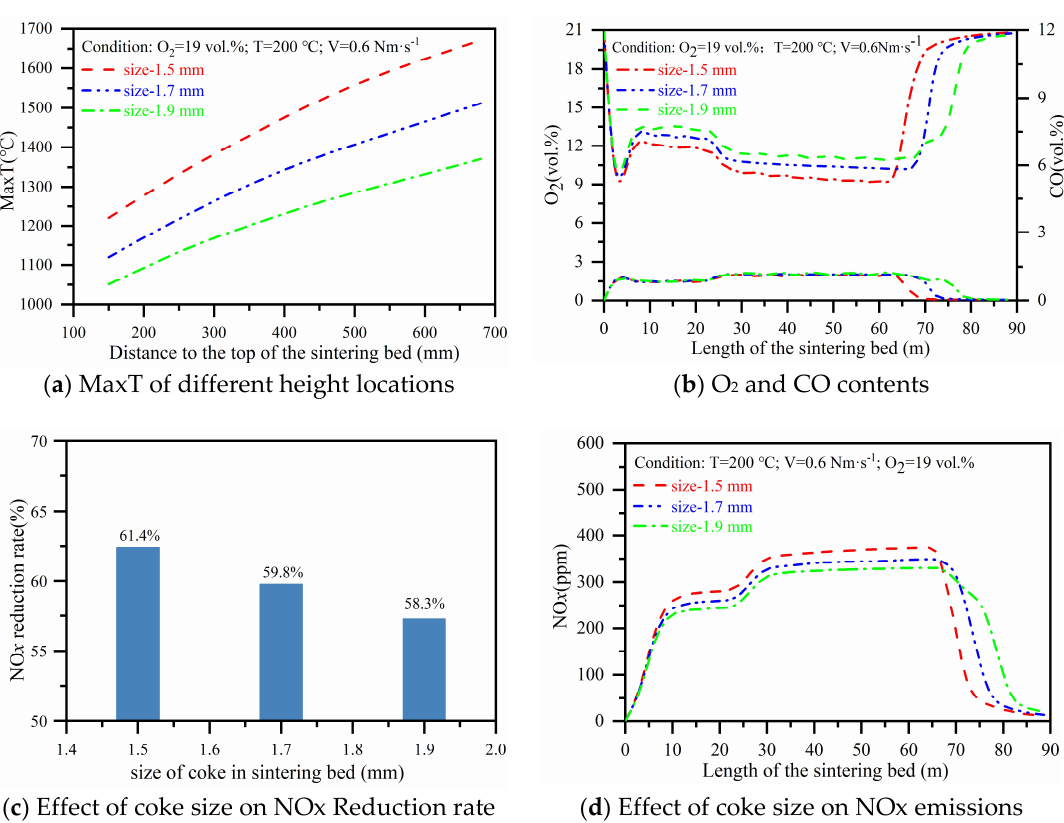
Figure 9. E ff ects of coke size on NOx, CO, and O 2 contents in flue gas and